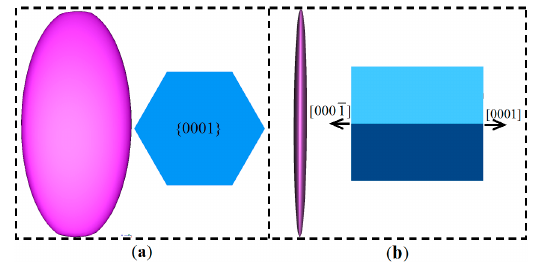
Figure 6. <0001> pole figures corresponding to the primary zinc-rich crystals ( a ) A & B in Figure 3a and ( b ) C & D in Figure 3f, respectively.